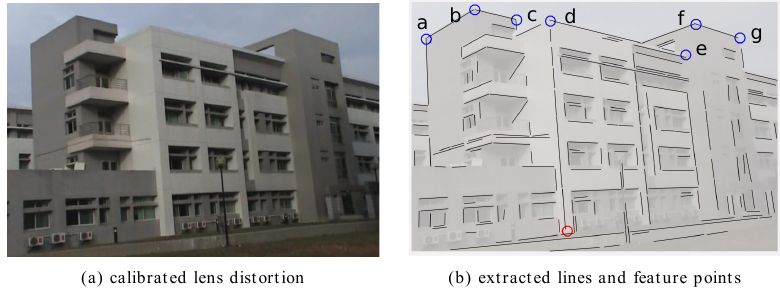
Figure 15. A test case of a video frame cut of a real building; the resolution is of 704 × 480 pixels. ( a ) A video frame calibrated using straight line segments; ( b ) Extracted lines and feature points for vanishing point estimation and 3D modeling.